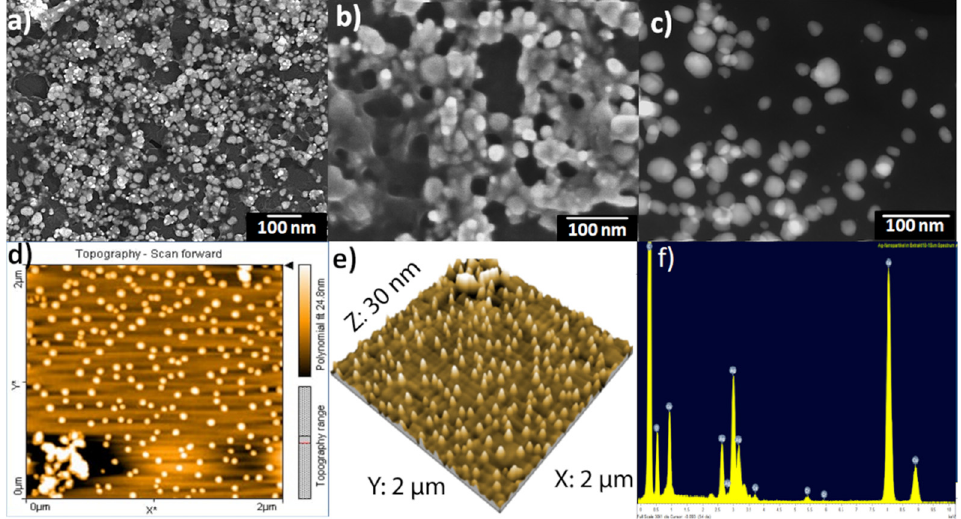
Figure 2. SEM images of Hypericum perforatum L. phytochemicals ‐ capped AgNPs ( a , b ); scanning transmission electron microscopy dark ‐ field (STEM ‐ DF) image ( c ); AFM image of phytochemicals ‐ capped AgNPs colloidal deposited as a film on glass slide by spin coating, scan scale: 2 μ m × 2 μ m, the color bar shows the scale in Z-direction ( d ); 2 µ m × 2 µ m AFM topography image of phytochemicals- dispersive X-ray (EDX) for phytochemicals-capped AgNPs ( f